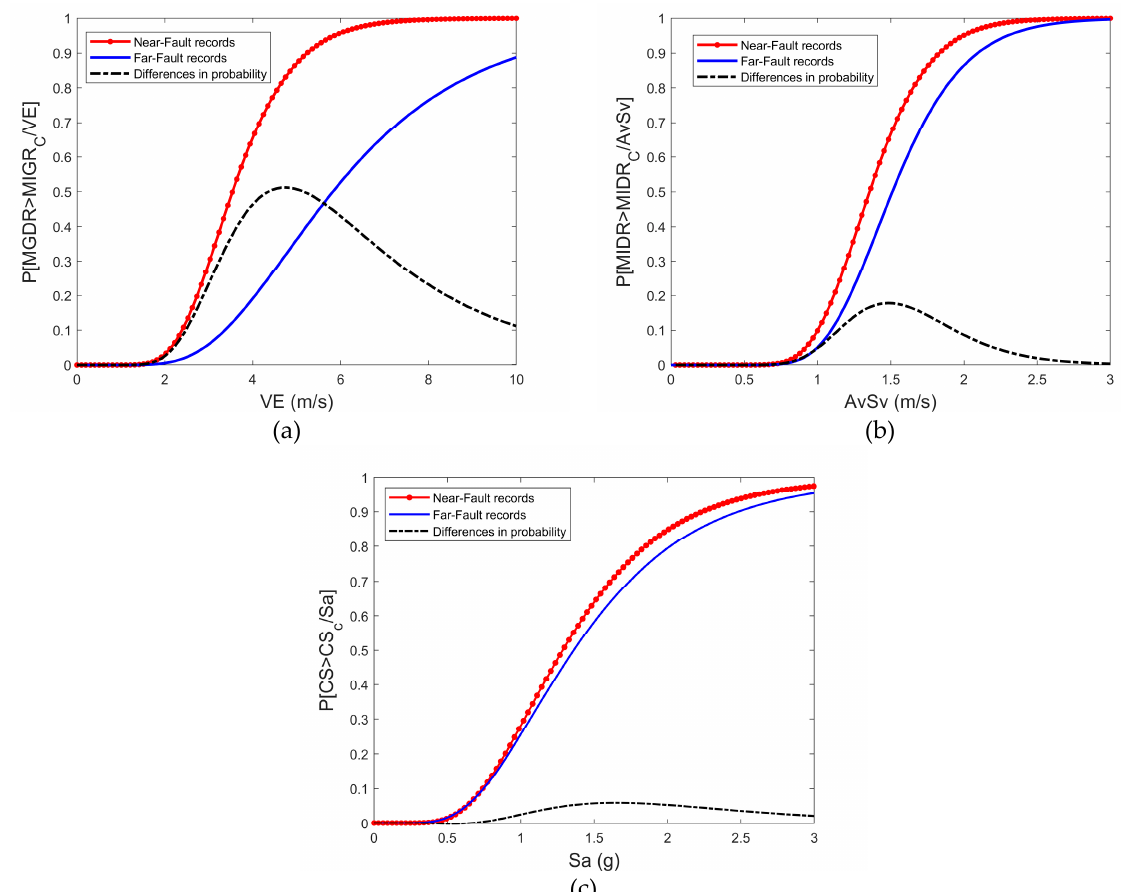
Figure 13. Fragility function comparison for near- and far-fault records; ( a ) the threshold to be exceeded is MGDR C = 0.02, the selected IM is VE; ( b ) the threshold to be exceeded is MIDR C = 0.02, the selected IM is AvSv; ( c ) the threshold to be exceeded is CS = 0.3, the selected IM is Sa.